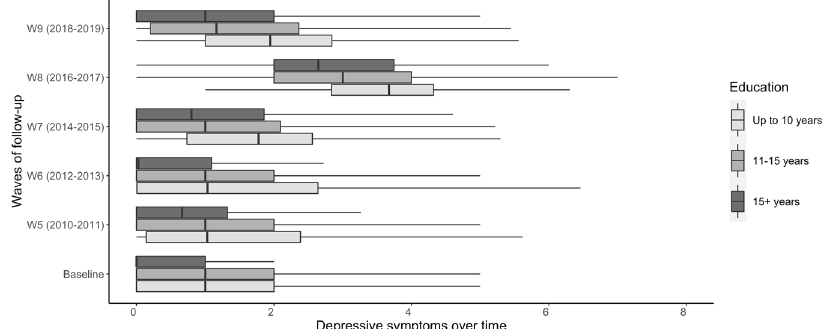
Fig. 1 The average distribution of depressive symptoms across all waves of data collection over the 14-year follow-up strati fi ed by years of completed schooling at baseline. W5-W9 symbols stand for the wave number of the follow-up.